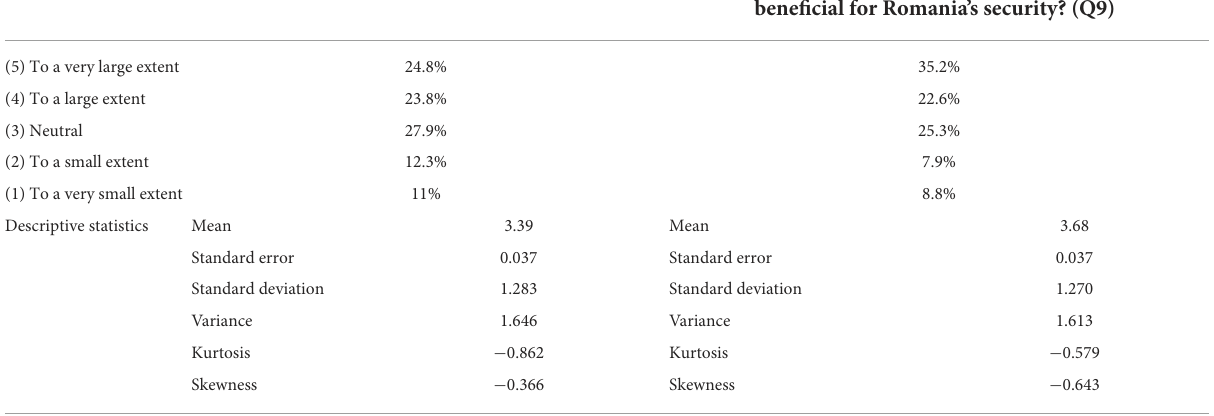
TABLE 6 The opinion of the participants regarding the state of Romania as a NATO member state. To what extent do you feel protected by the fact that Romania is a NATO member state?